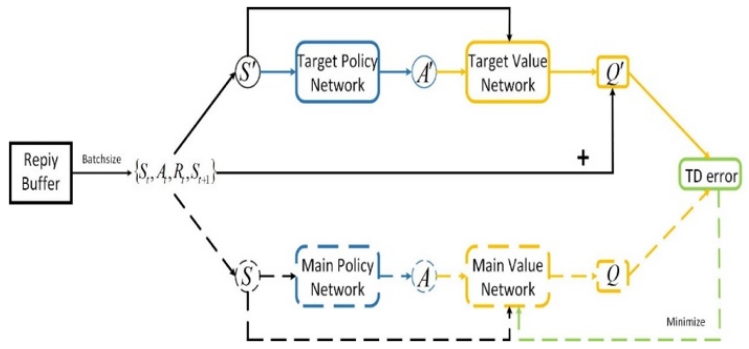
Figure 2. DDPG training flow chart.